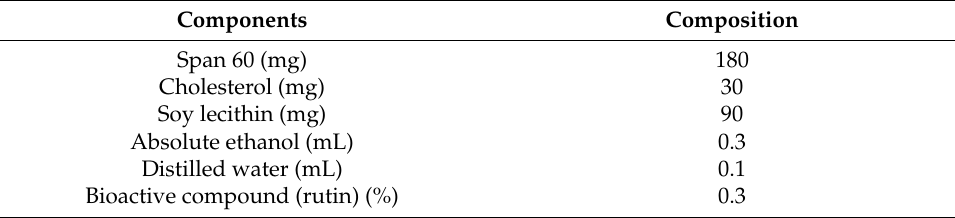
Table 1. The composition of medicated (rutin) proniosomal gel formulation.